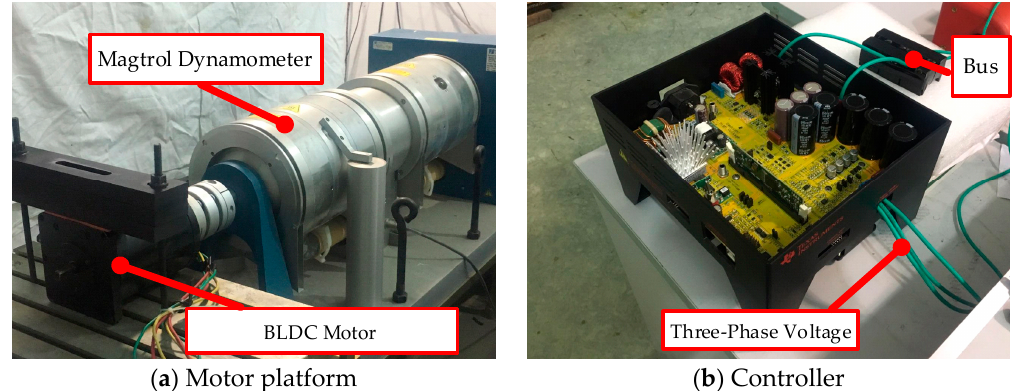
Figure 21. Experimental platform.